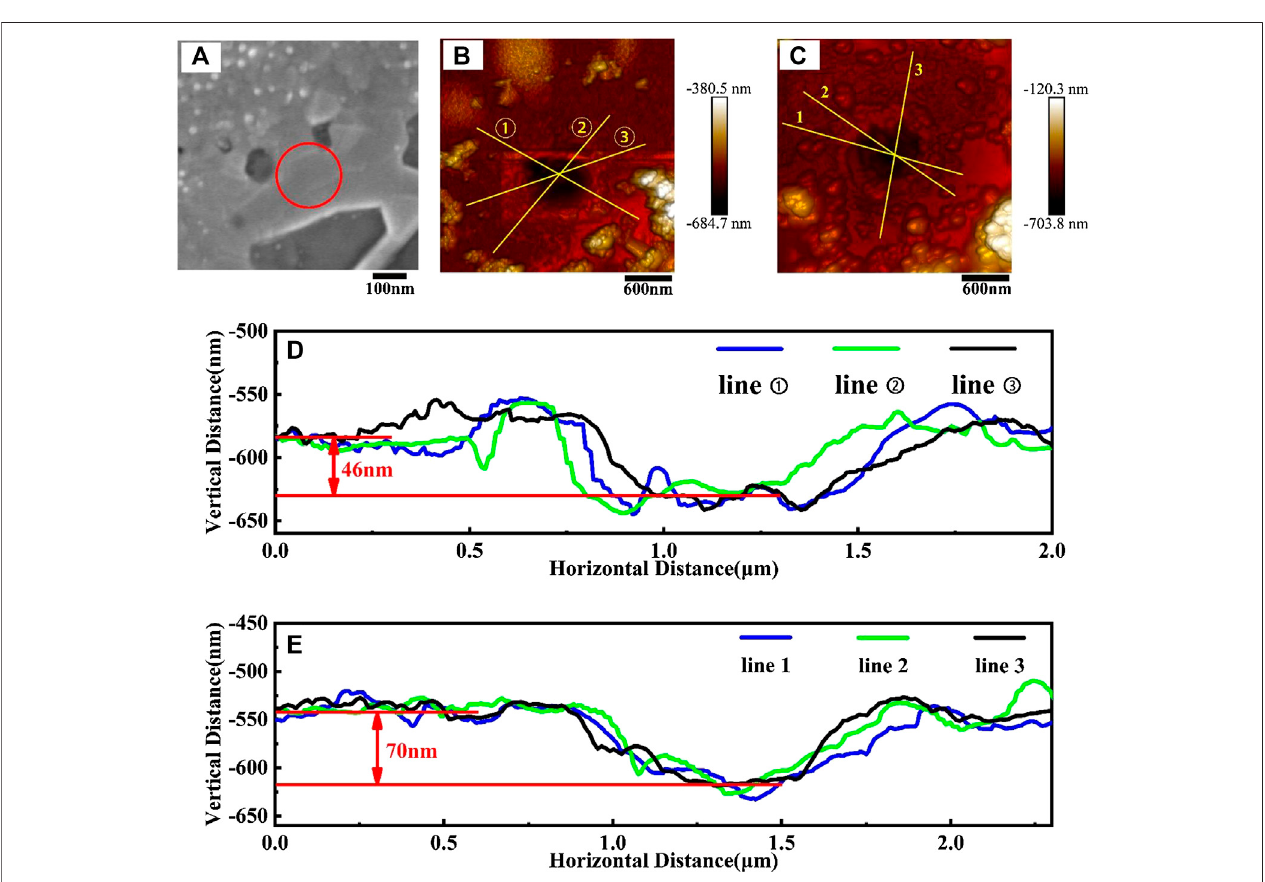
FIGURE7|(A) SEMimagearoundpositiononein Figure5 , (B,C) aretheAFMtopographicimagearoundlocationsoneandtwoin Figure5 , (D,E) arethepro fi les along the three different solid yellow lines in fi gure (B) and fi gure (C)